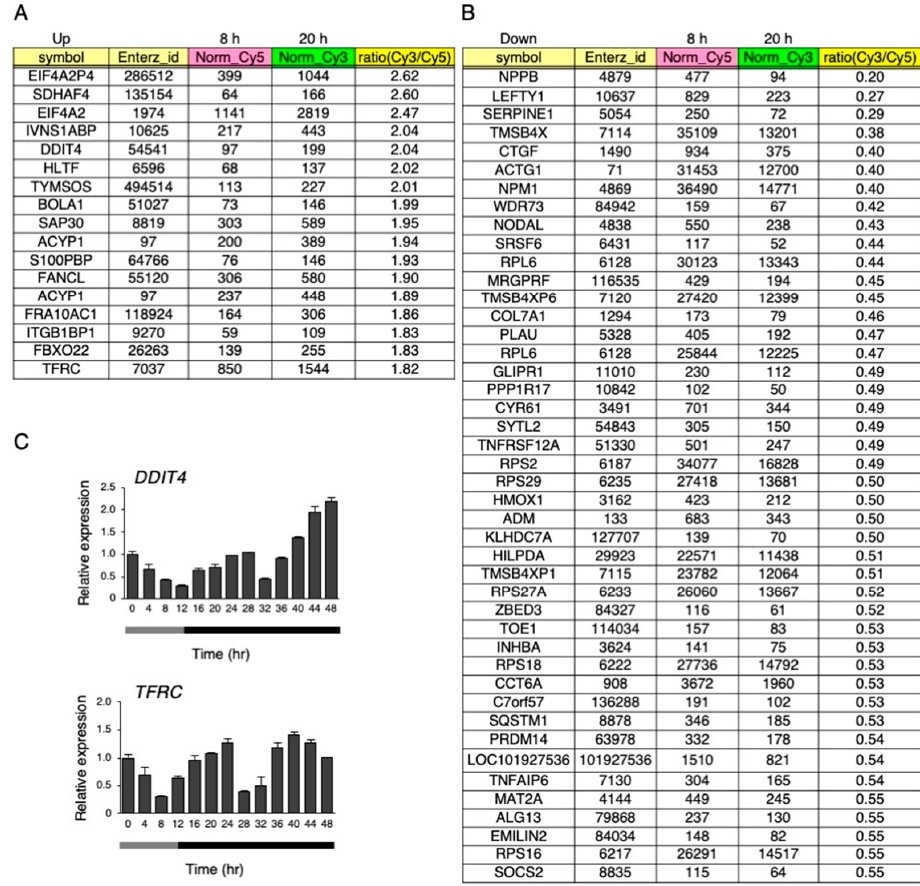
Figure 8. Up- or downregulated genes under the temperature rhythm. ( A ) and ( B ) Microarray analysis at 8 and 20 h on day 6 under the temperature rhythm. Total RNA mixed from three independent samples were used. Upregulated genes with a ratio (Cy3/Cy5) of more than 1.8-fold at 20 h are listed after the value of the normalized_Cy3 was cut off at more than 100 ( A ). Downregulated genes with a ratio (Cy3/Cy5) less than 0.56-fold at 20 h are listed after the value of the normalized_Cy5 was cut off at more than 100 ( B ). ( C ) The expression levels of DDIT4 and TFRC under the temperature rhythm in hiPSCs; 0 h refers to the start of day 5 of the temperature rhythm. The temperature was set at 33 °C from 0 to 12 h (gray bar) and then at 37 °C from 12 to 48 h (black bar). Data are presented as the means ± SEM relative to 0 h; n = 3 for each comparison. The p values for the rhythmicity of DDIT4 and TFRC were determined by a cosinor analysis with p = 0.07 and p < 0.01, respectively.